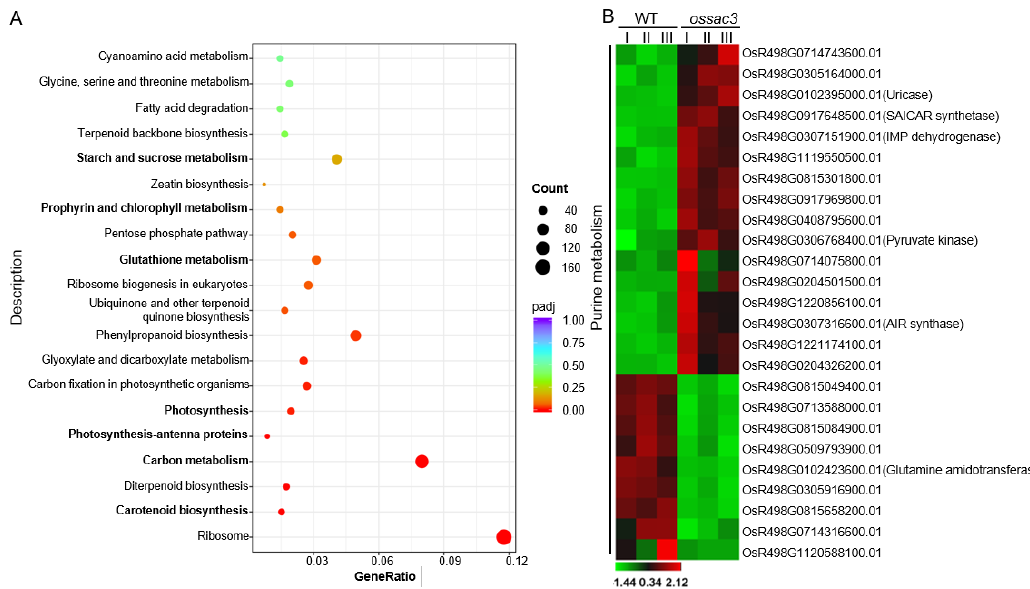
Figure 4. Transcriptome analysis between the wild type (WT) and the OsSAC3 mutant. ( A ): KEGG enrichment of differentially expressed genes in OsSAC3 transcriptome data. The enriched pathways are listed on the left; ( B ): Heatmap showing the expression patterns of selected genes in the process of purine metabolism related process. Data are from three biological replicates (I, II and III).